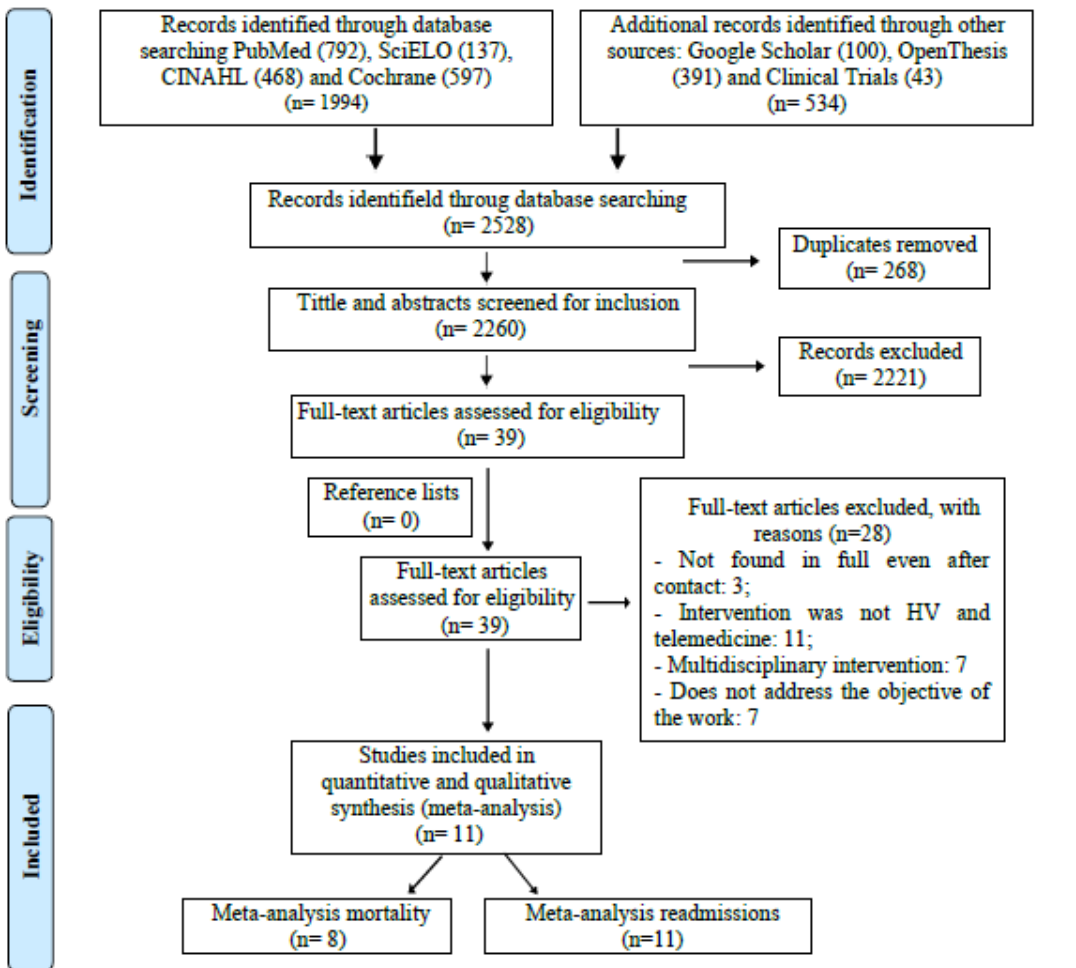
Figure 1. PRISMA flow diagram. PRISMA flow diagram showing study identification, selection, eligibility, and inclusion. Eleven articles were selected for this review. HV: Home Visit.